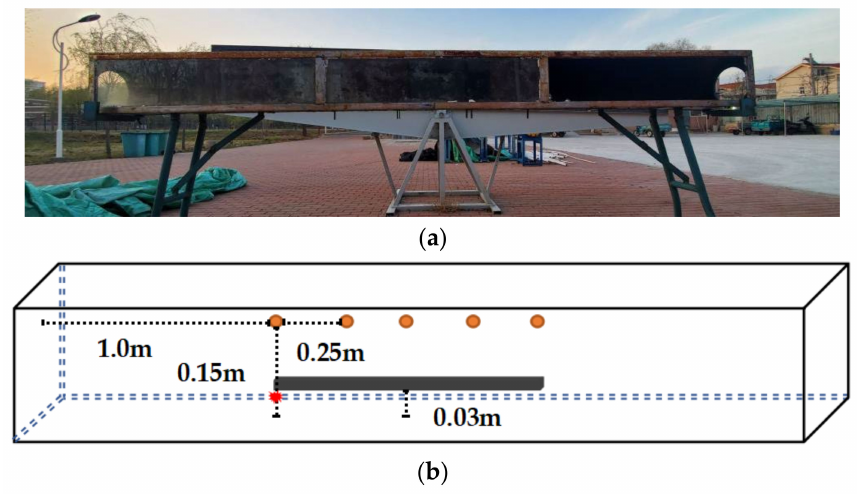
Figure 3. ( a ) Experiment tunnel; ( b ) simulation